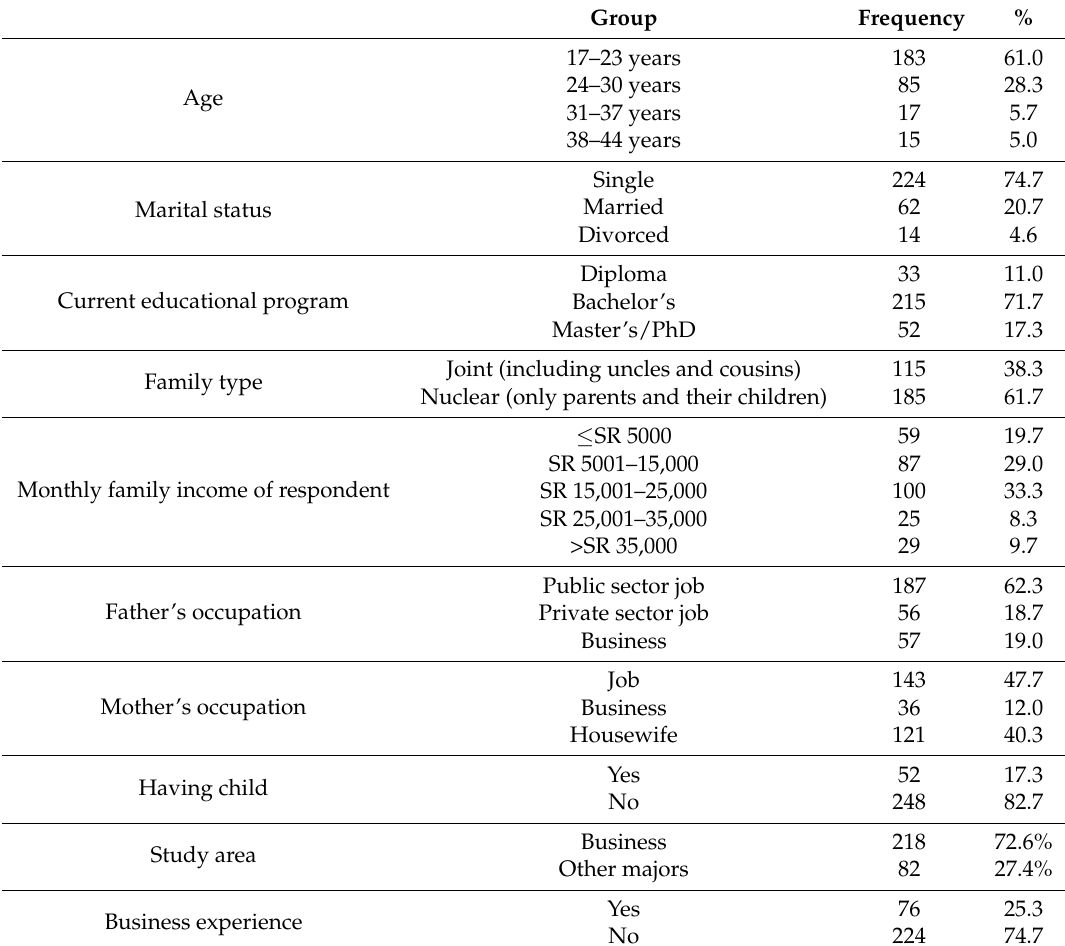
Table 3. Descriptive snapshots of the dataset.